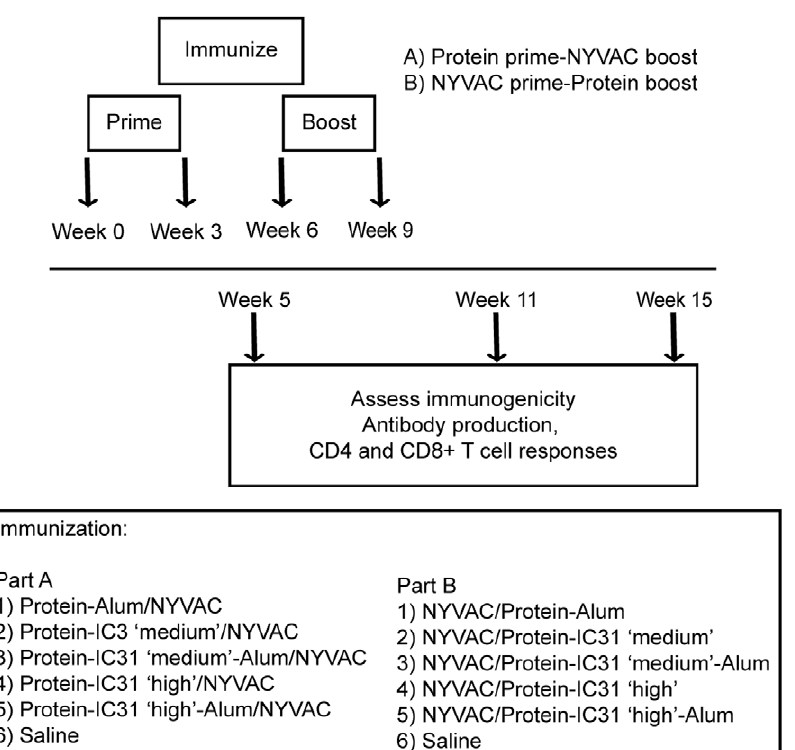
Figure 1. Schematic representation of the vaccination protocol. Three to five mice for each timepoint were injected at weeks 0 and 3 with the prime and at weeks 6 and 9 with the boost. Mice were either injected with saline (negative control, three mice per group), with protein plus alum alone, with protein plus a medium or high dose of IC31 alone, with protein plus alum and a medium or high dose of IC31, or with NYVAC-CN54 (five mice per each group per timepoint). At week 5, 11 or 15, a subset of mice were sacrificed and antibody and T-cell responses were analyzed ex vivo